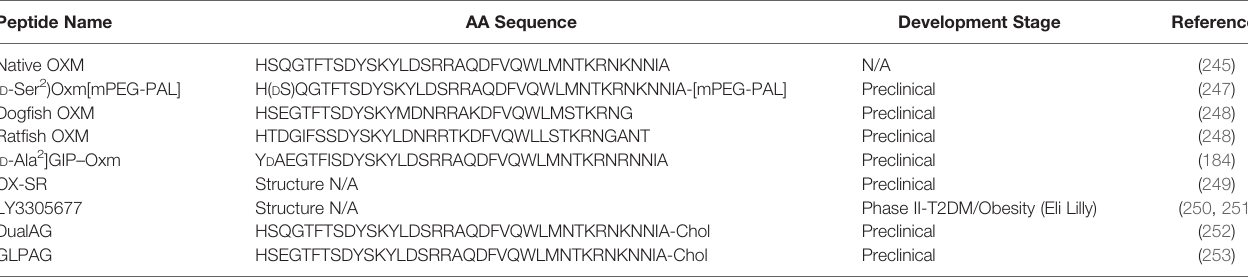
TABLE 4 | Oxyntomodulin-based therapeutic